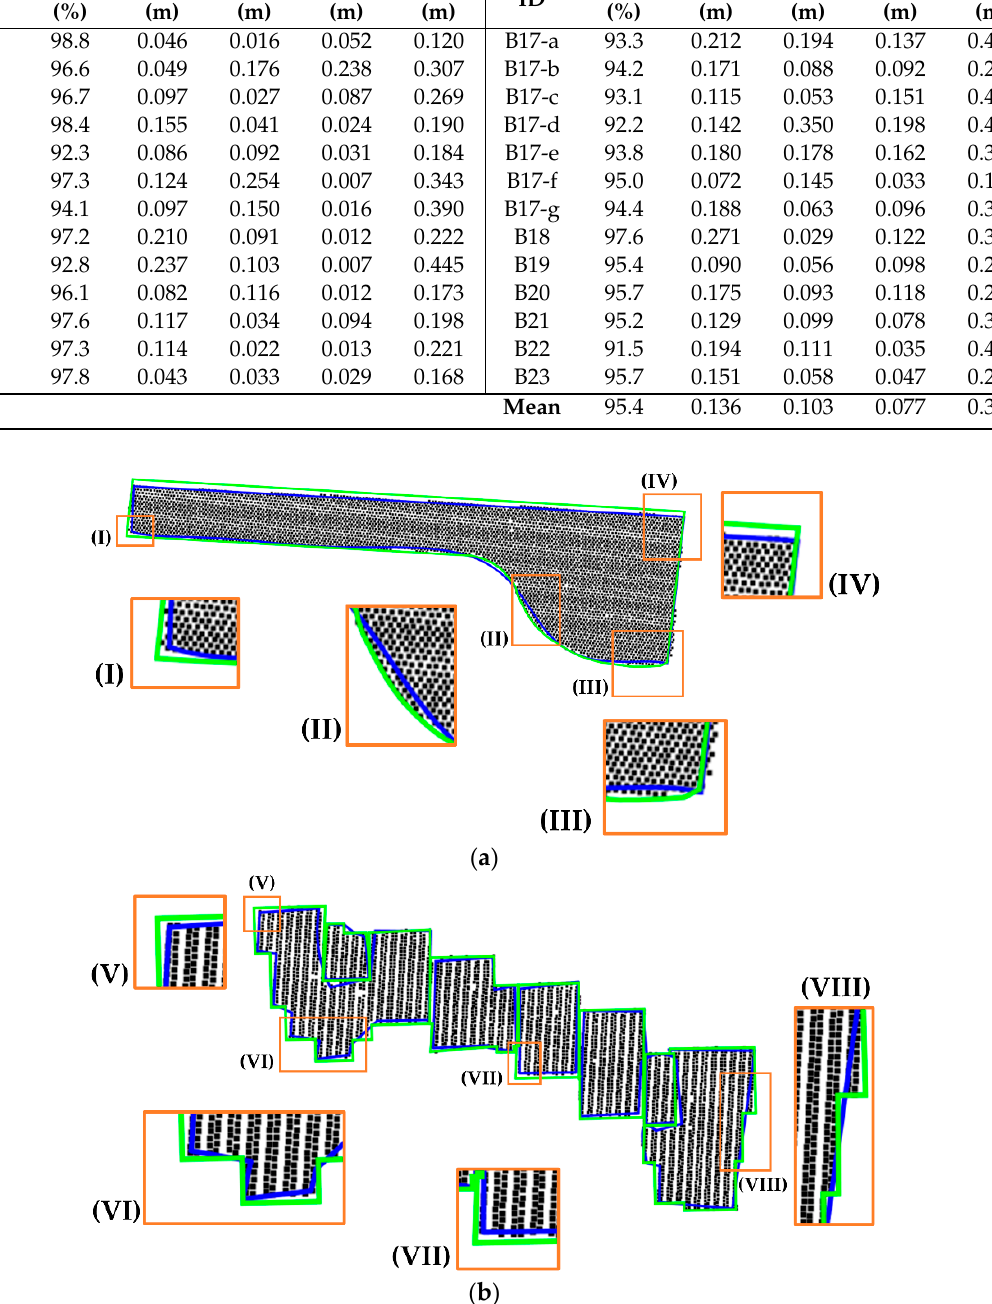
Figure 14. Representation of the reference (green) and regularized boundary (blue) from the proposed method for buildings B6 ( a ) and B17 ( b ). Table 1. Quality parameters using the iterative CD-spline regularization method for selected buildings from both datasets.